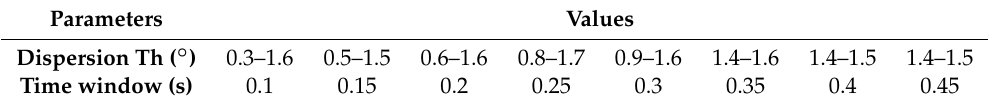
Table 2. Optimum parameters using the criteria of number of fixations and mean time fixation.